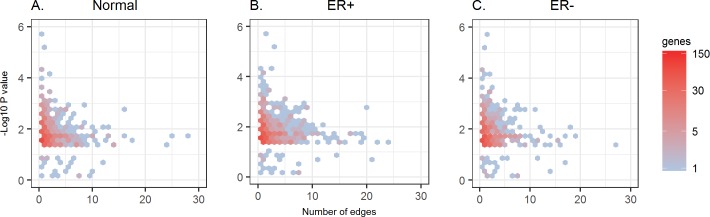
Hubness of a gene and its association with survival time in (A) normal tissue, (B) ER+ tumor tissue and (C) ER- tumor tissue. Y-axis: -log10 (p-value) of a gene in the Cox model. X-axis: the number of edges connected to a gene. The gene set consists of 961 genes that are significant associated with survival time (p-values <0.05) and 39 genes that are not significant but are known to be related to breast cancer (see Methods).